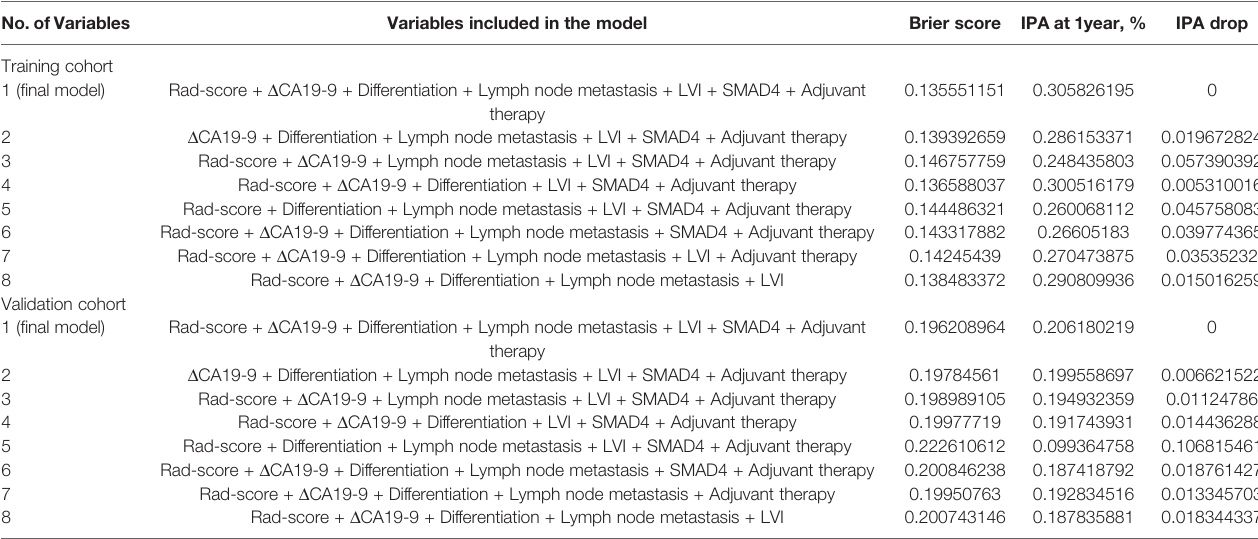
TABLE 3 | Comparison of the different models regarding RFS in the training and validation cohorts. No. of Variables Variables included in the model Training cohort 1 ( fi nal